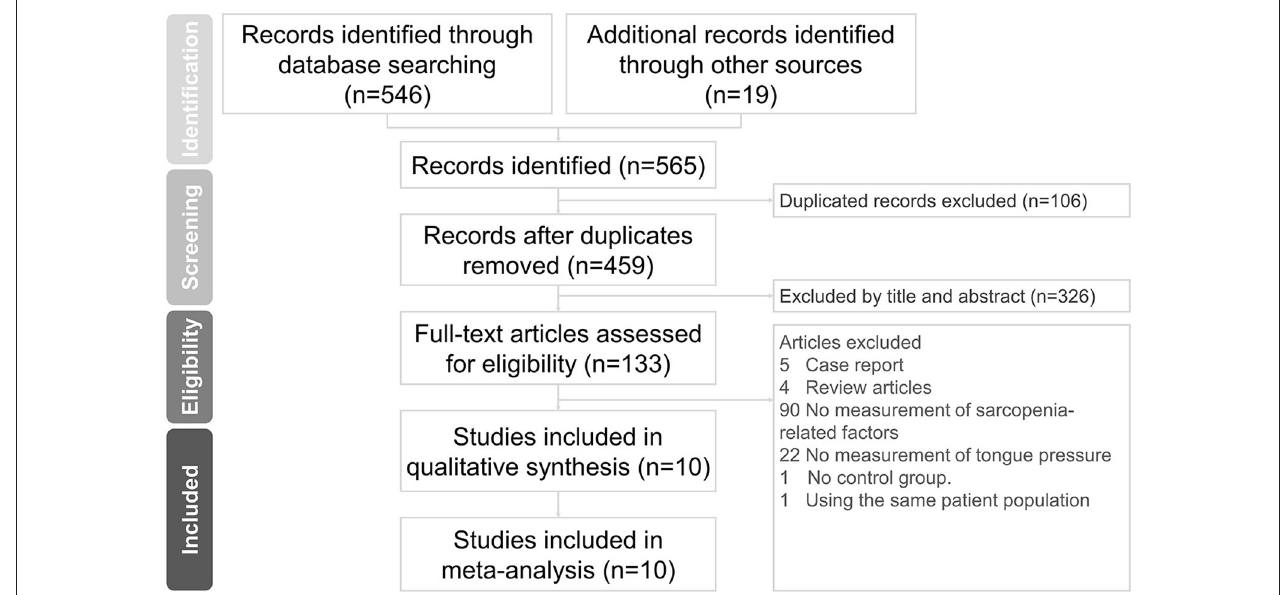
FIGURE 1 | Preferred Reporting Items for Systematic Reviews and Meta-Analyses (PRISMA) flow diagram for the